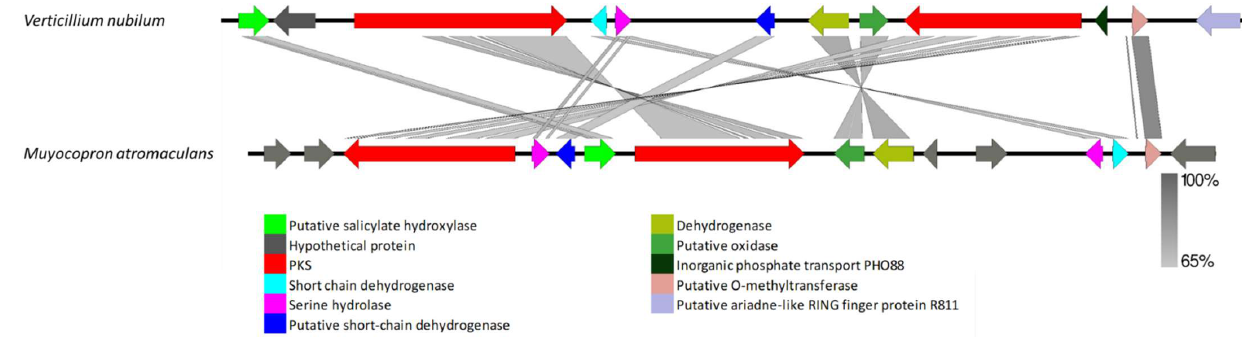
Figure 9. Comparison of putative cluster genes for Verticillium nubilum VNR-PKS-I-4 and the lijiquinone biosynthesis cluster of Muyocopron atromaculans . The arrowheads indicate the direction of transcription and the types of genes common to the two clusters being compared are displayed in the same color. Shaded lines represent similarities between nucleotide sequences.